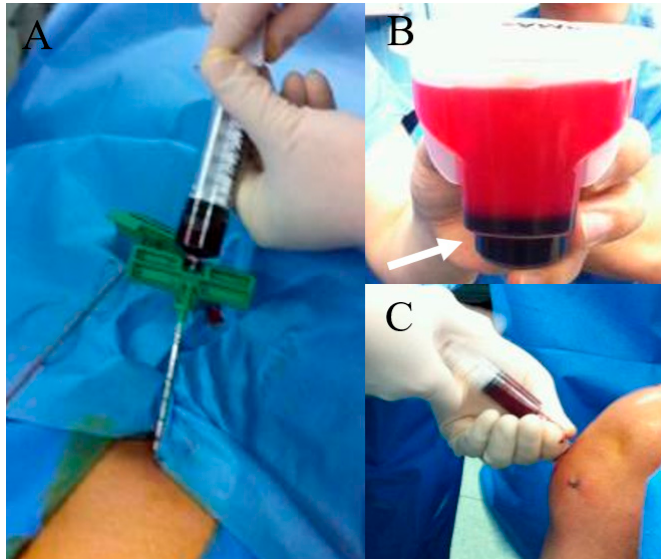
Figure 2. BMAC preparation and knee joint injection. ( A ) bone marrow aspiration at anterior iliac rim; ( B ) After centrifugation and some procedure, dark-colored BMAC (white arrow) was obtained; ( C ) BMAC injection to the knee joint with osteoarthritis.